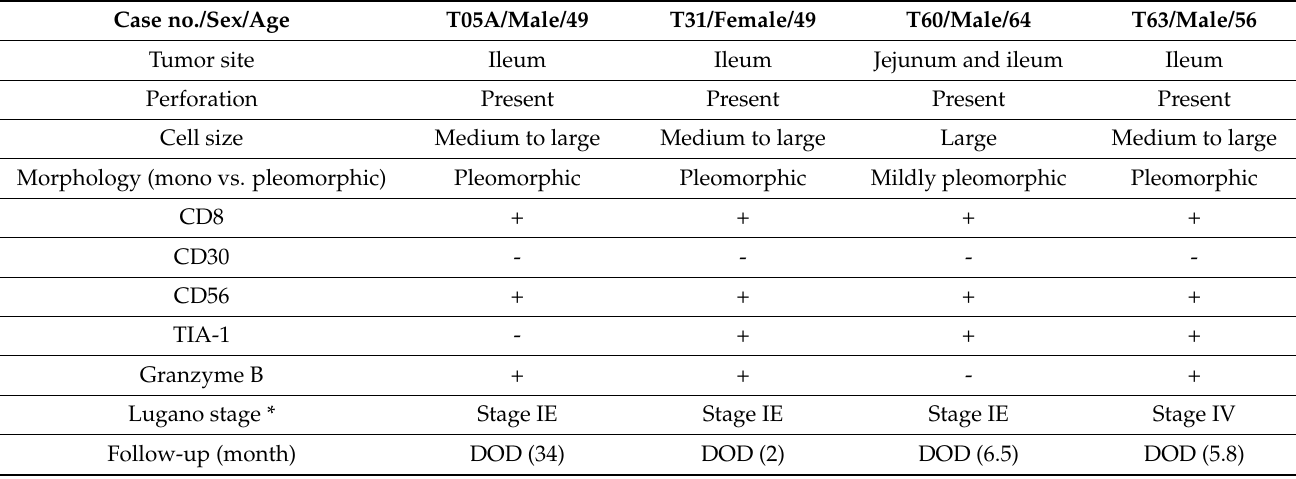
Table 1. Clinicopathological features of the four borderline